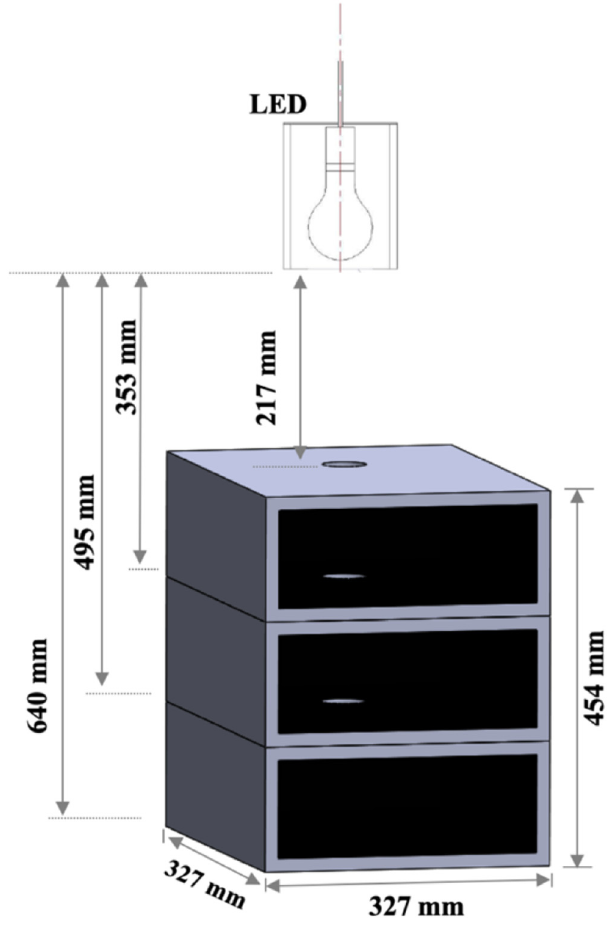
Fig. 2. Experimental setup using an LED source.